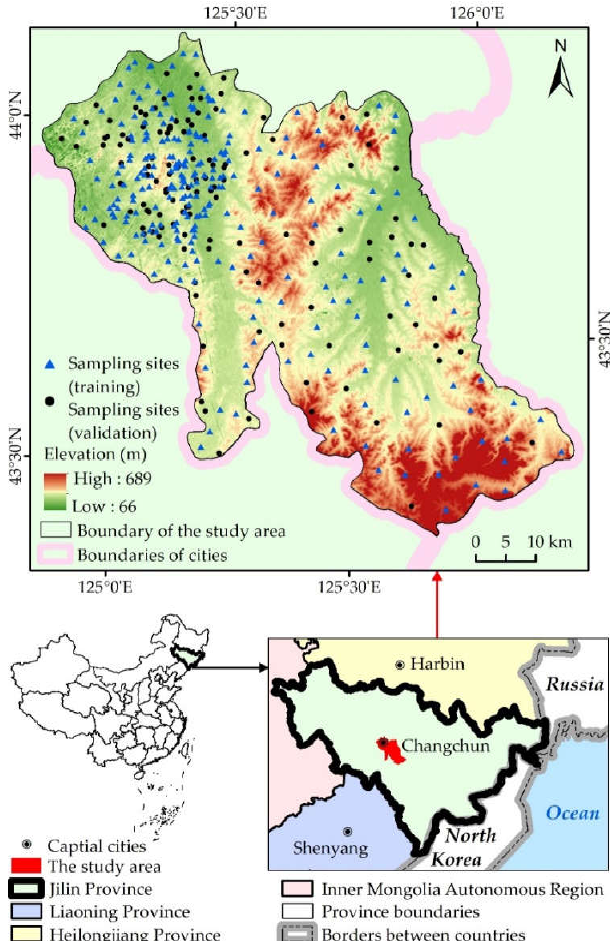
Figure 1. Location of study area in China and soil sampling sites.